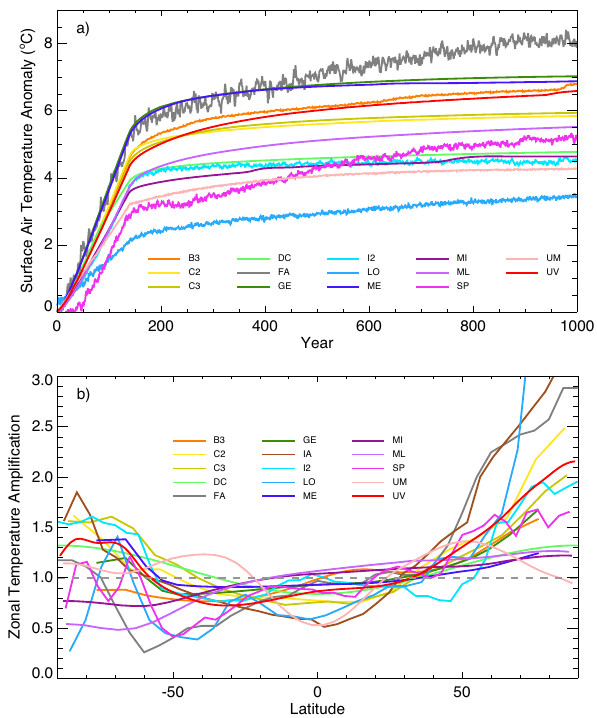
Fig. 4. Surface air temperature (a) and zonal temperature ampli- fication (b) for all 15 participating models, from a 1% increase to 4 × CO 2 simulation. The zonal temperature amplification is calculated as the zonal anomaly divided by the global average anomaly at year 140, which roughly corresponds to the time of CO 2